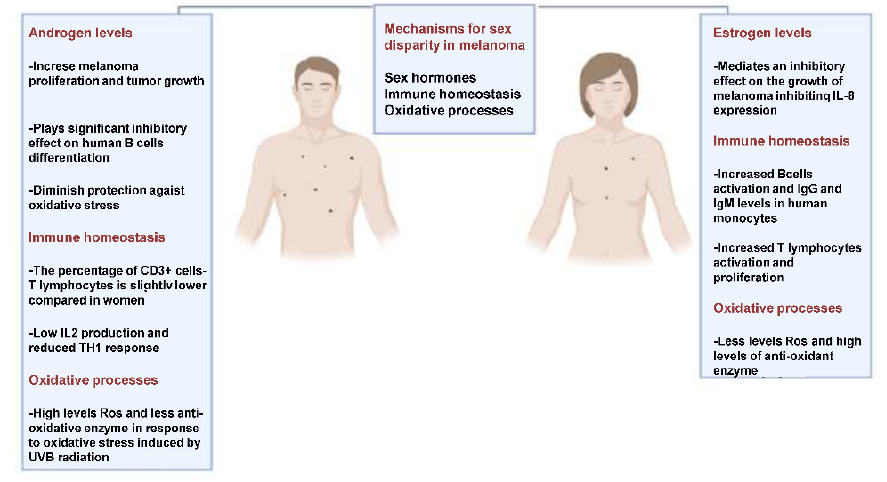
Figure 1. The main underlying mechanisms sex disparities in melanoma